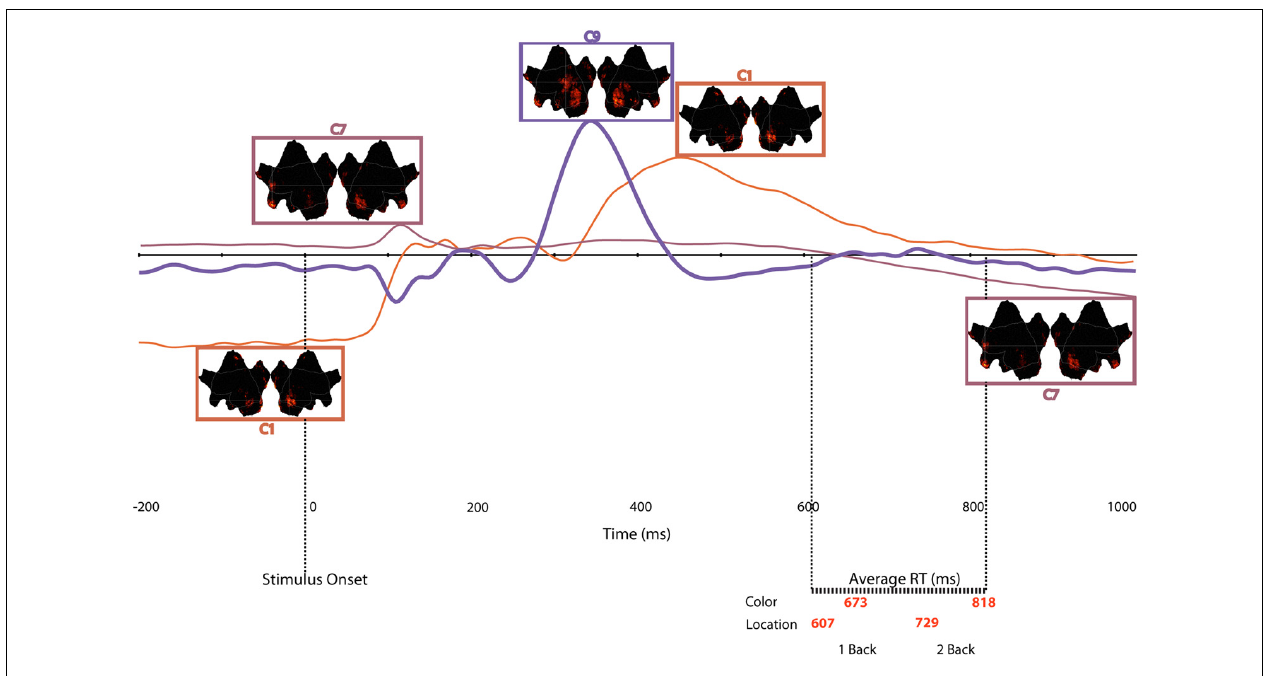
FIGURE 8 |Time course of each temporospatial component in relation to stimulus onset and mean reaction times for each experimental condition. Note that border of source maps are color coded to match